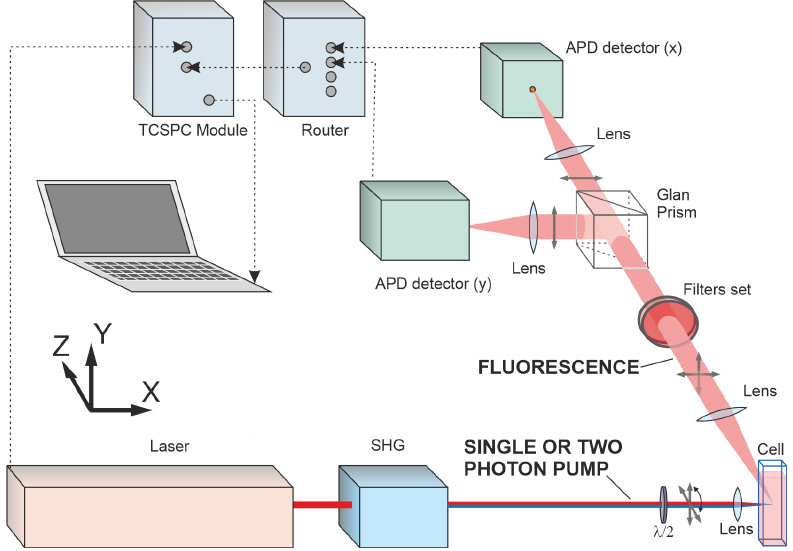
Figure 2. Optical schematic of the experimental